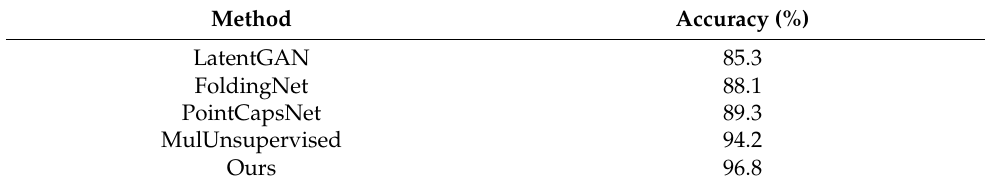
Table 2. ShapeNetParts classification accuracy of 20% of the training data.